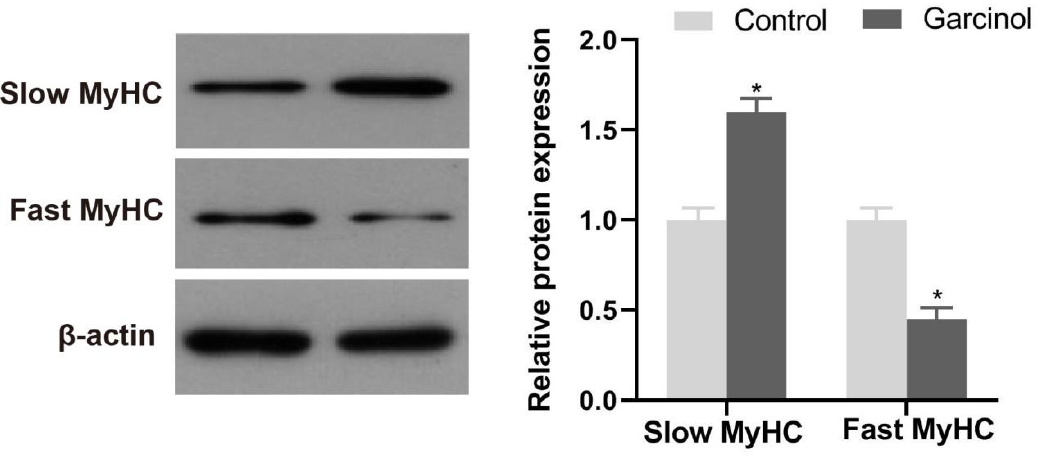
Figure 5. Effect of garciniol on slow MyHC and fast MyHC expression in C2C12 myotubes. Data are shown as the mean ± SE, n = 10. * Different from the control group, p < 0.05. 2.6. Garcinol Inhibits the p300 ‐ Dependent Acetylation of PGC ‐ 1 α in C2C12 Myotubes